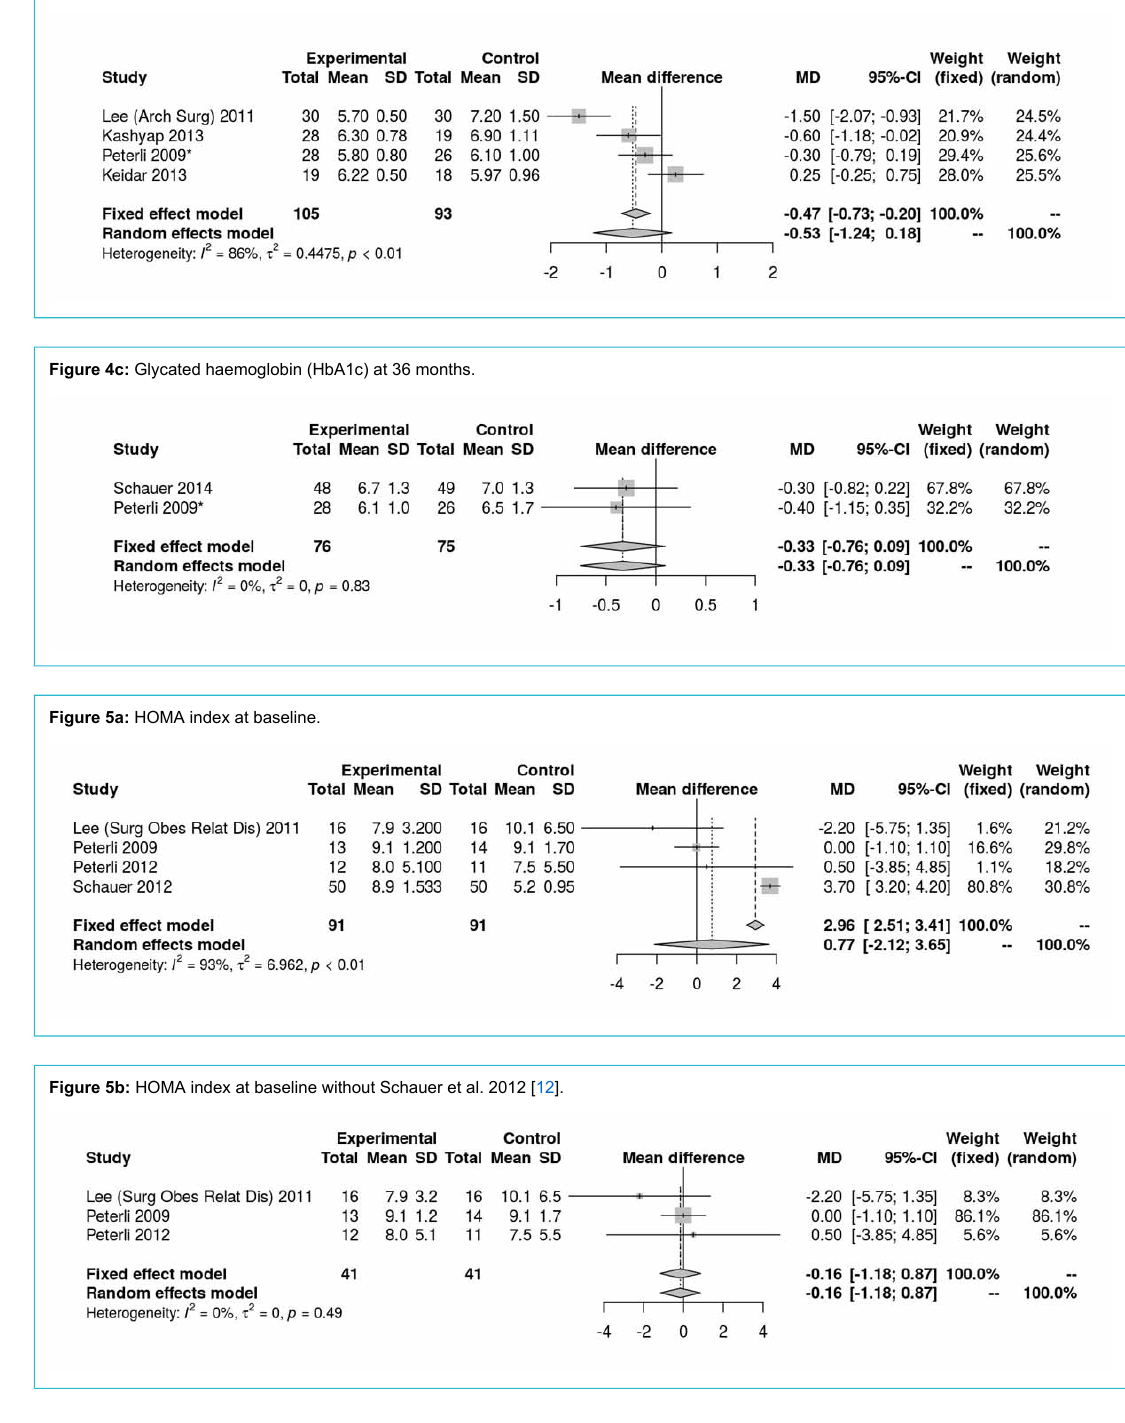
Figure 4b: Glycated haemoglobin (HbA1c) at 12 months.